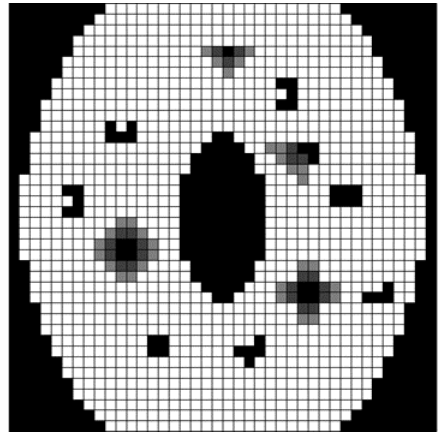
Figure 4. Motion space state map.